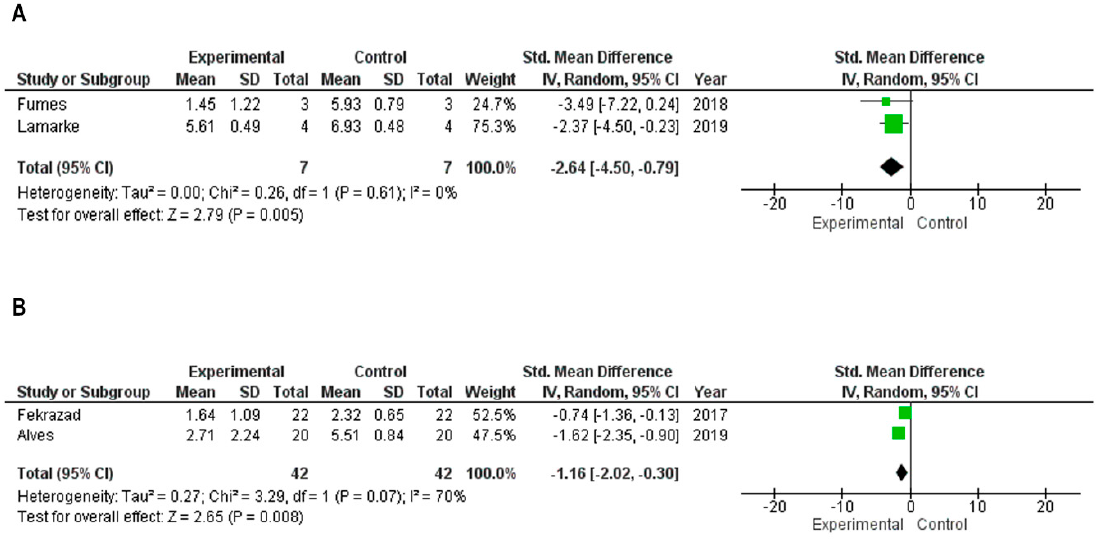
Figure 2. Results of the meta-analyses. The experimental group was formed based on colony forming units (CFU / mL) in the microorganisms that received photodynamic therapy (PDT). The control group was formed based on colony forming units (CFU / mL) in microorganisms that did not receive photodynamic therapy. ( A ) Meta-analysis in the in vitro study design. ( B ) Meta-analysis in the randomized clinical trials.